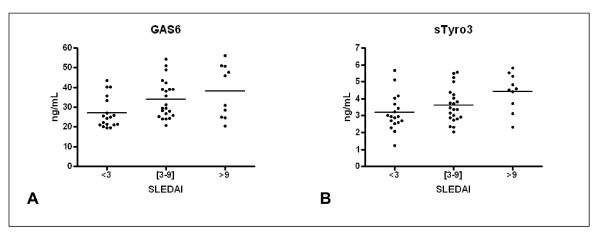
Correlation of growth arrest-specific gene 6 protein (GAS6) and sTyro3 with Systemic Lupus Erythematosus Disease Activity Index (SLEDAI). Systemic lupus erythematosus (SLE) patients were classified according to SLEDAI into a low (n = 18), intermediate (n = 22) or high activity group (n = 10). Values were significantly different using analysis of variance (ANOVA) (GAS6, P = 0.015; sTyro3, P = 0.021).